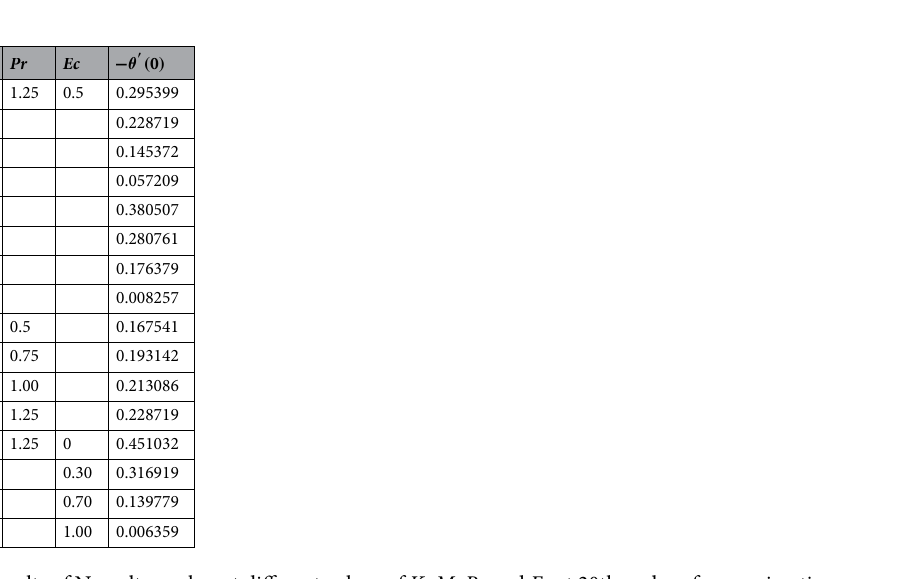
Table 3. Results of Nusselt number at different values of K , M , Pr and Ec at 20th-order of approximations.